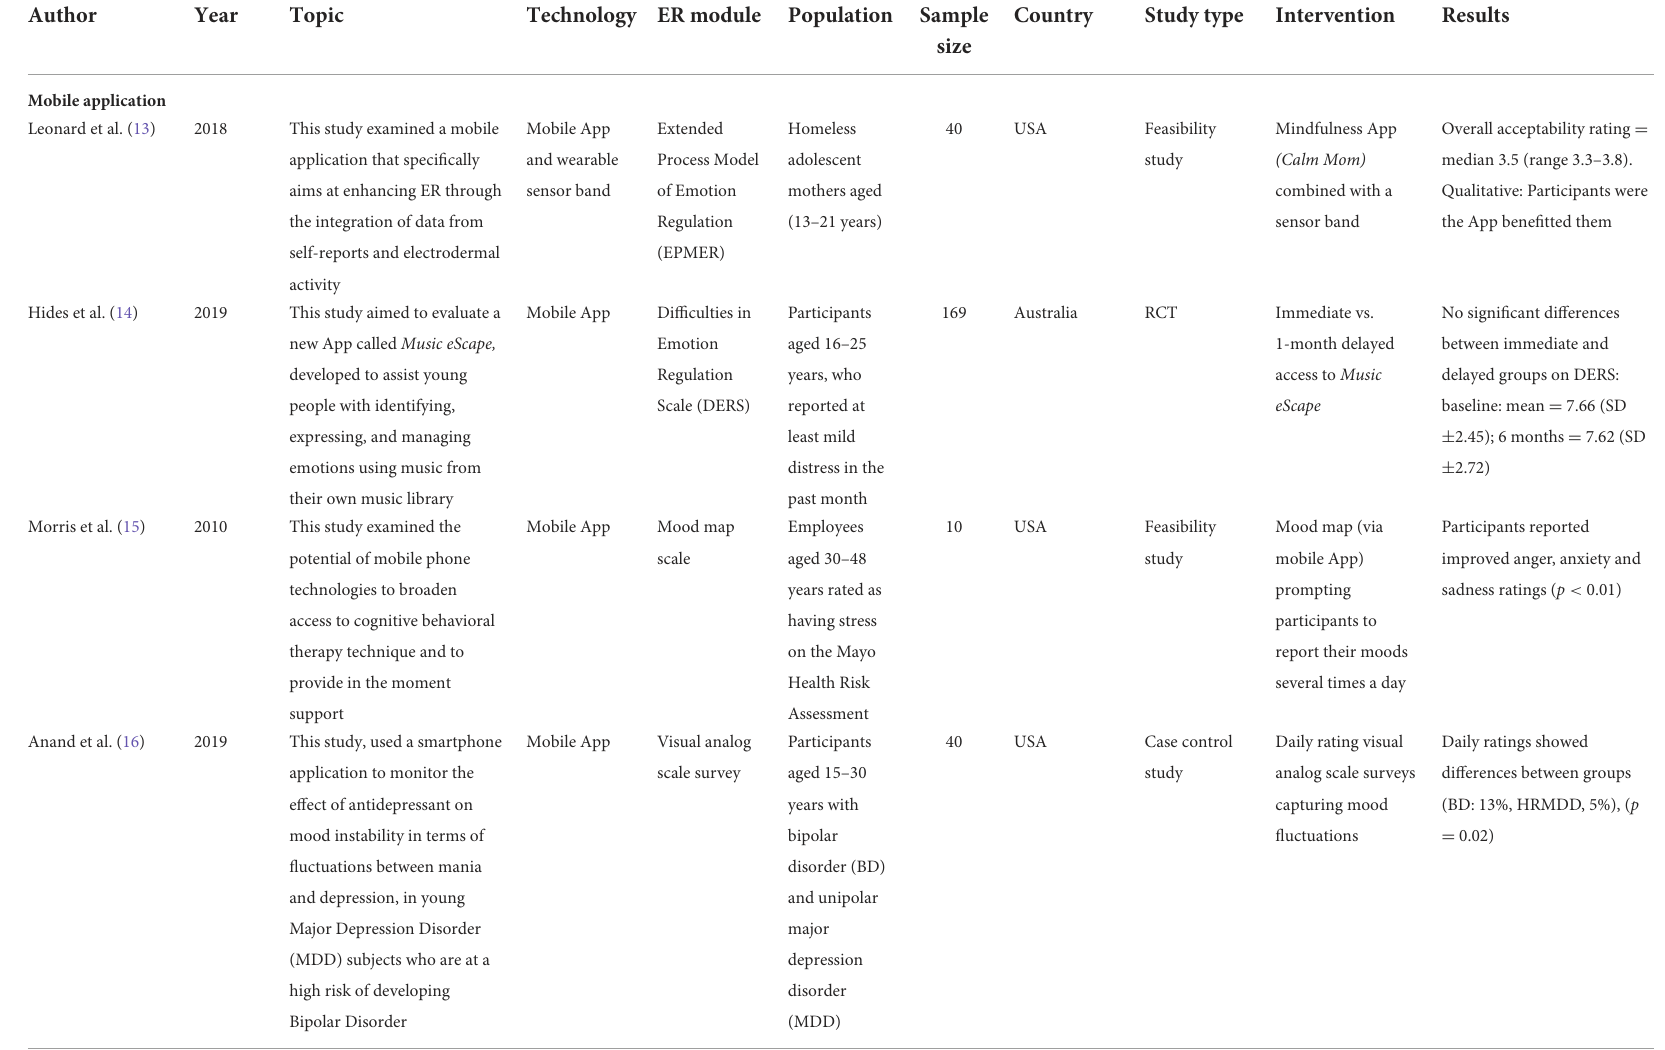
TABLE 1 Characteristics of included